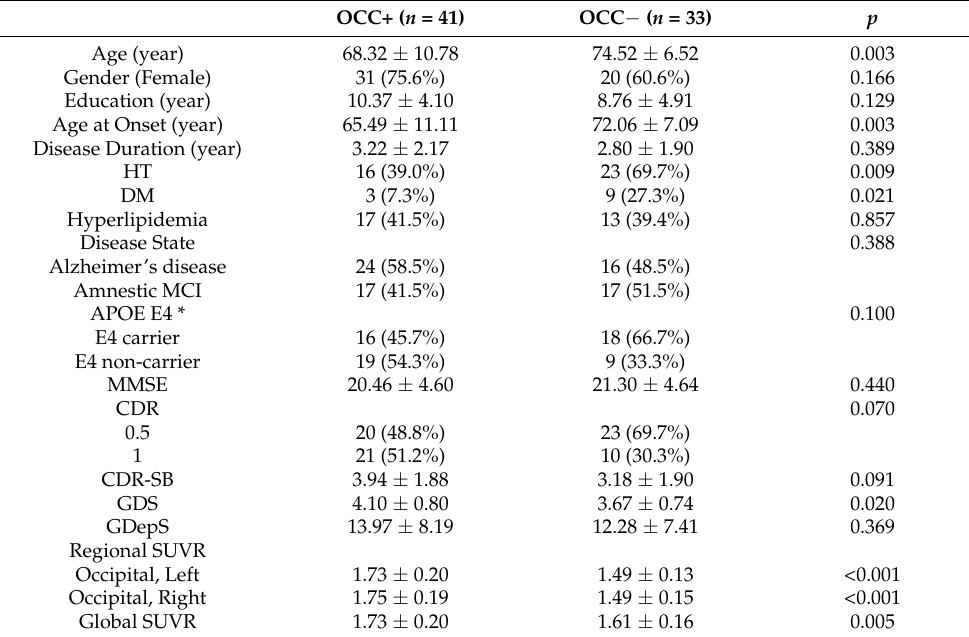
Figure 1. Representative [18F]-Florbetaben PET images and regional cortical thinning compared between the occipital A β positive group (OCC+) and occipital A β negative group (OCC − ) groups. ( a ) [18F]-Florbetaben amyloid PET image of an occipital amyloid-beta (A β ) positive patient. ( b ) [18F]-Florbetaben amyloid PET image of an occipital A β negative patient. ( c , d ) Regional differences in cortical thickness between each group and control are shown. Maps at a false discovery rate corrected p < 0.05 are shown with age, sex, education, and intracranial volume serving as covariates. The color scale bar represents the z-score. Table 1. Demographics and clinical